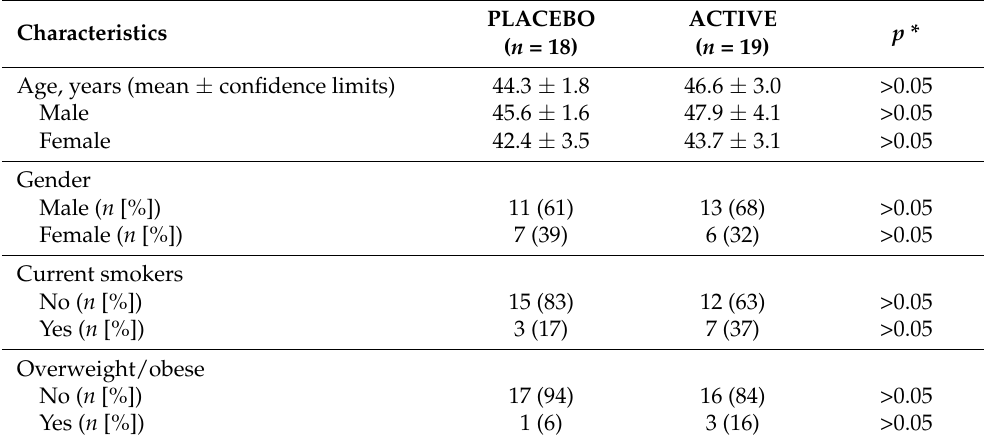
Table 1. Baseline characteristics of subjects: comparison between the two experimental groups.